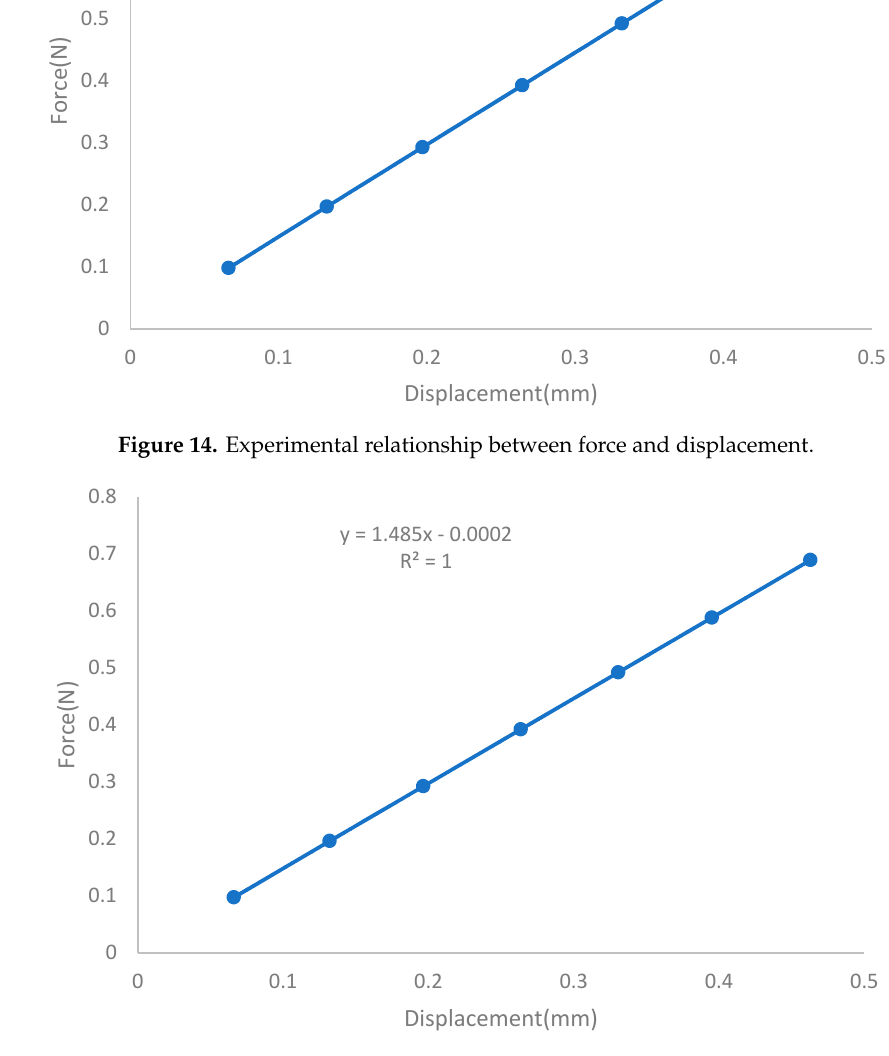
Figure 15. Theoretical relationship between force and displacement.